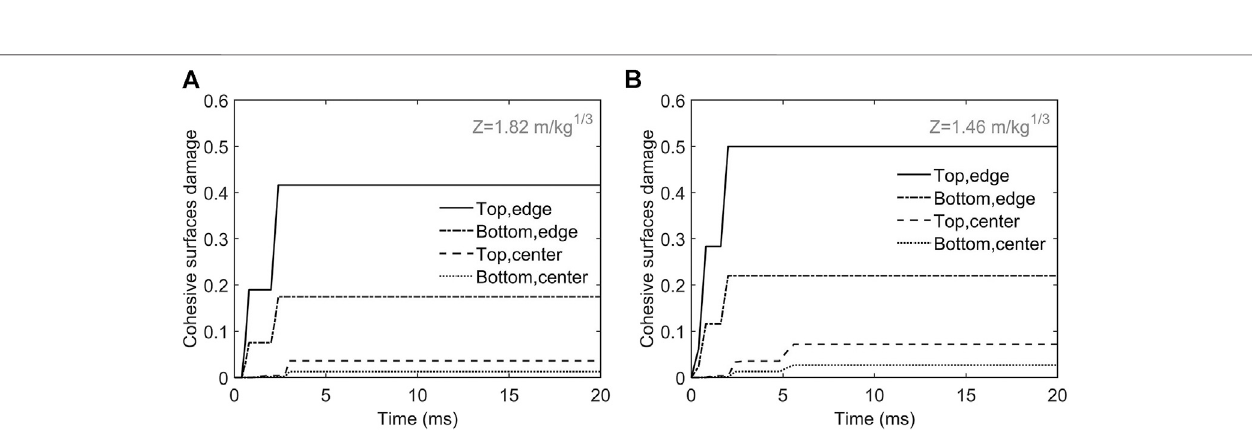
FIGURE 10 | The damage evolution at various locations of the 0.22/0.36 [0 ° /0 ° ]/0.22 plate. (A) With the impulsive load of Z (cid:2) 1 . 82 m / kg 1 / 3 . (B) With the impulsive load of Z (cid:2) 1 . 46 m / kg 1 / 3 .